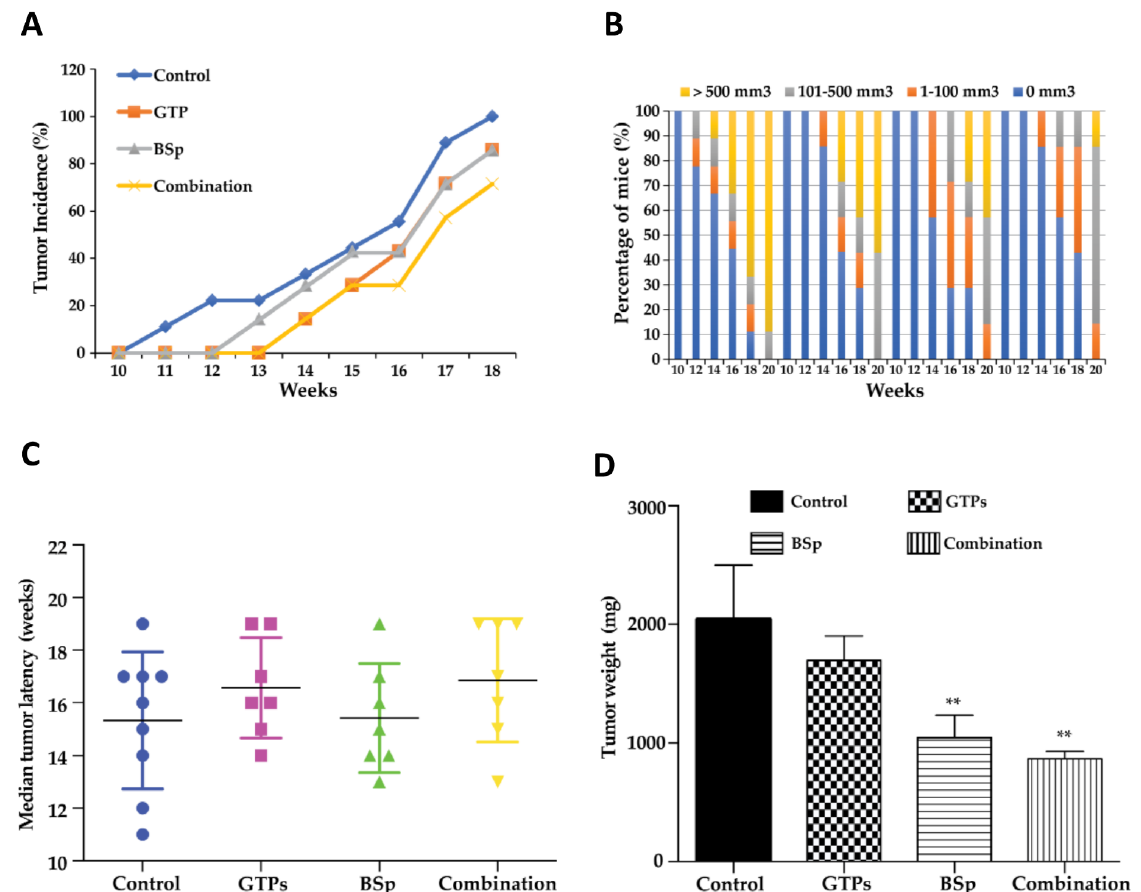
Figure 2. Breast tumor growth in SV40 mice exposed to different dietary botanicals. SV40 mice were administered with control diet, 26% BSp diet, 0.5% GTPs in drinking water or BSp and GTPs in combination (BSp + GTPs) upon weaning at 3 wks of age. Dietary treatment was maintained throughout the study until the termination of the experiment, and mice across each treatment group (control, BSp, GTPs and combination) were evaluated for tumor growth weekly. ( A ) Tumor incidence was measured in percentage over the whole population. ( B ) Tumor growth volume was measured in rate across the entire population. ( C ) Median tumor latency between BSp, GTPs and the combination treatment group. ( D ) Average tumor weight between BSp, GTPs and the combination treatment group. Columns represent mean; bars, standard error; ** p -value < 0.01, significantly different from the control group.